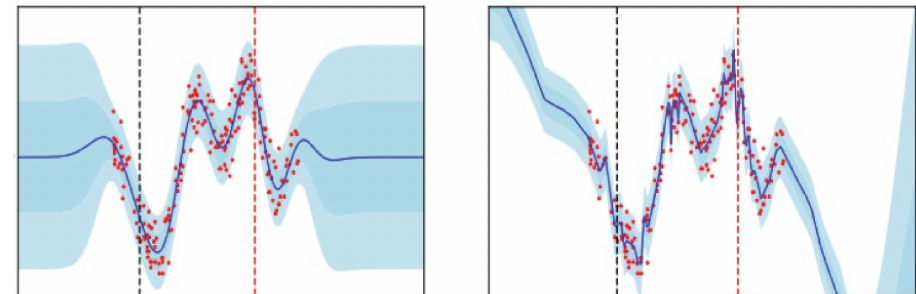
Figure 5. Predictions and attached uncertainties on a toy dataset from a squared exponential (SE) kernel ( left ) and a deep kernel learning (DKL) kernel ( right ). Outside the training points, the SE kernel model reverts to its zero mean with high uncertainty, while the DKL extrapolates confidently (adapted with permission from [77],